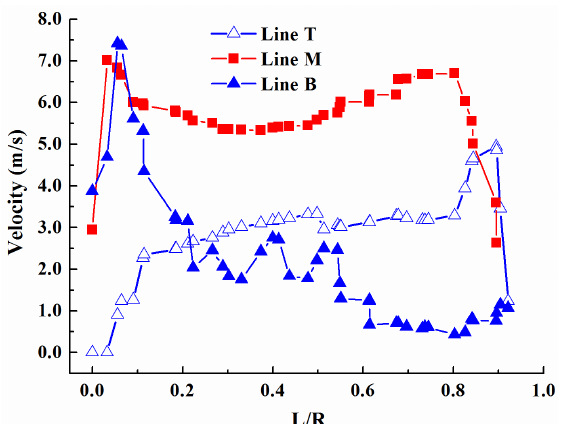
Figure 7. Spatial distribution of air